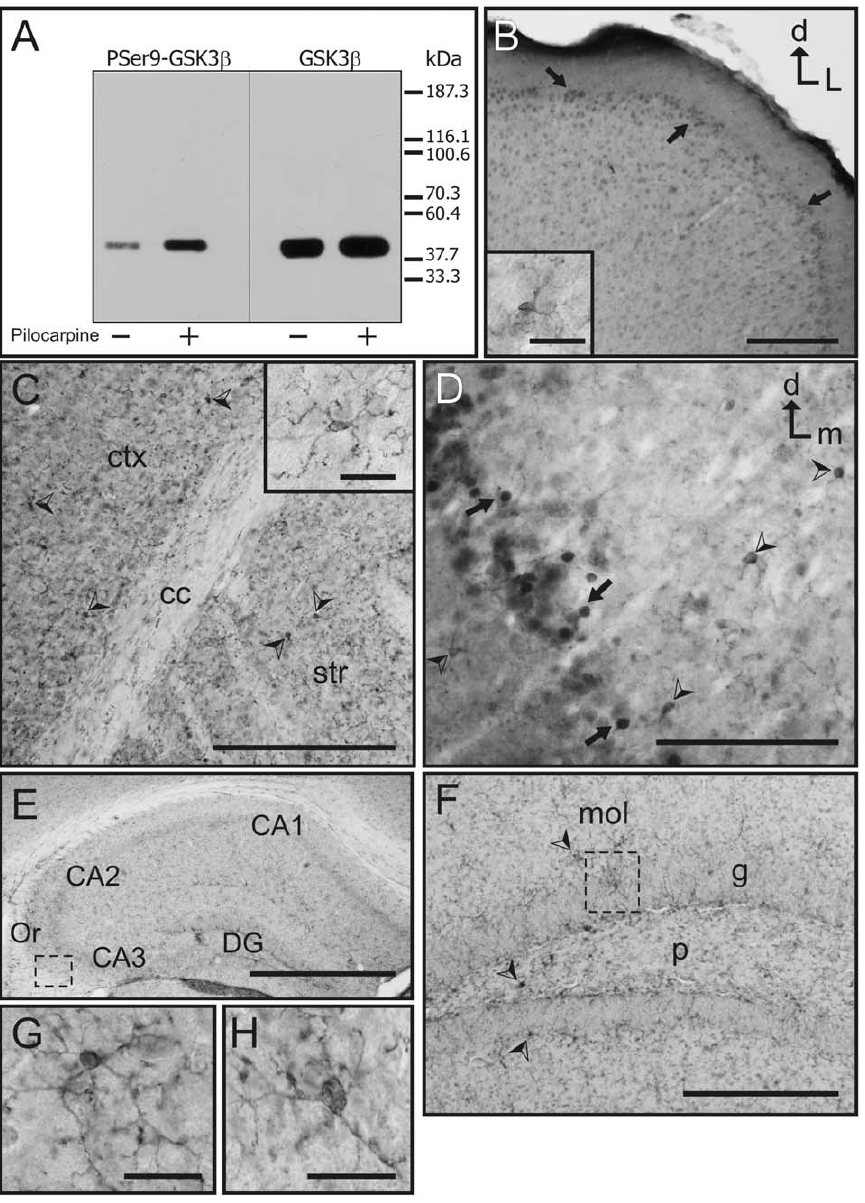
Figure 6. Light microscopy localization of pSer9GSK3 b in the mouse brain. A) Immunoblot of mouse brain lysates showing the specificity of the pSer9GSK3 b antibody used and its comparison with an immunoblot for GSK3 b . For both blots, brain samples from control ( 2 ) and pilocarpine- treated ( + ) animals were used. Both antibodies detected only one protein band of equal molecular weight on the immunoblots. The pSer9GSK3 b antibody detected the basal pSer9GSK3 b and the pilocarpine-induced increase in pSer9GSK3 b . B) pSer9GSK3 b labeling in the motor cortex. Note the abundance of labeled neurons (arrows) in the superficial layers while neuronal labeling decreases progressively in deeper layers where microglia labeled cells are more frequent. B-inset : detail of a labeled microglia cell located in the deeper layers of the motor cortex showing staining in the cell body and processes. C) pSer9GSK3 b labeling in cortical and subcortical areas. Low magnification image showing most of the labeling in microglia (arrowheads) both in the somatosensory cortex (ctx) and in the striatum (str). C-inset : Detail of a labeled microglia cell in the striatum showing staining in the cell body and fine processes. D) Image of the piriform cortex where pSer9GSK3 b labeling is present both in neurons (arrows) and in microglia cells (arrowheads). Note that positive neurons are concentrated in one narrow strip, while microglia cells are present interspersed with labeled neurons and also in more medial and lateral areas. E) Low magnification image of pSer9GSK3 b labeling in the hippocampus. All hippocampal areas present almost exclusively glial staining. The boxed area is shown as a detail in G. F) Image of pSer9GSK3 b staining in different layers of the dentate gyrus showing immunolabeled microglial cells (arrowheads). Note the absence of immunostaining in neurons of the granule cell layer (g). The boxed area is shown in detail in H. G) Detail of a labeled microglia cell in the stratum oriens of the hippocampus showing intense immunostaining in the cell body and processes. H) Detail of a labeled microglia cell in the granule cell layer of the dentate gyrus showing intense immunostaining in the cell body and processes. [CA1, CA2, CA3: Cornu Amonis subfields; cc: corpus callosum; ctx: cortex; d: dorsal; DG: Dentate Gyrus; L: lateral; m: medial; mol: molecular layer of the DG; Or: stratum oriens; p: polymorphic layer of the DG. Str: striatum. Scale bars: 100 m m in E; 25 m m in B–D and F, 5 m m in B-inset, C-inset and G–H]